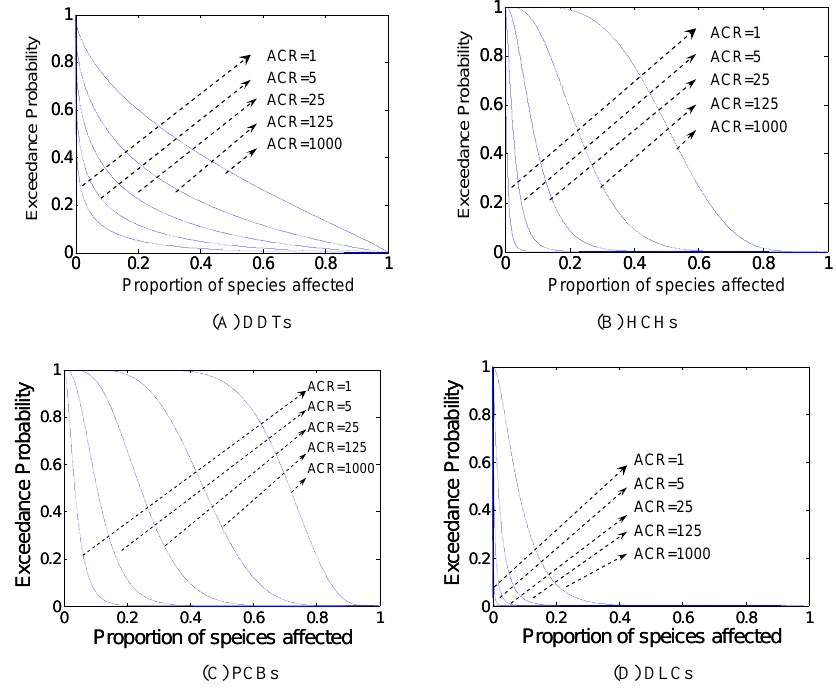
FIGURE 3. JPCs of DDTs, HCHs, PCBs, and DLCs in the Haihe